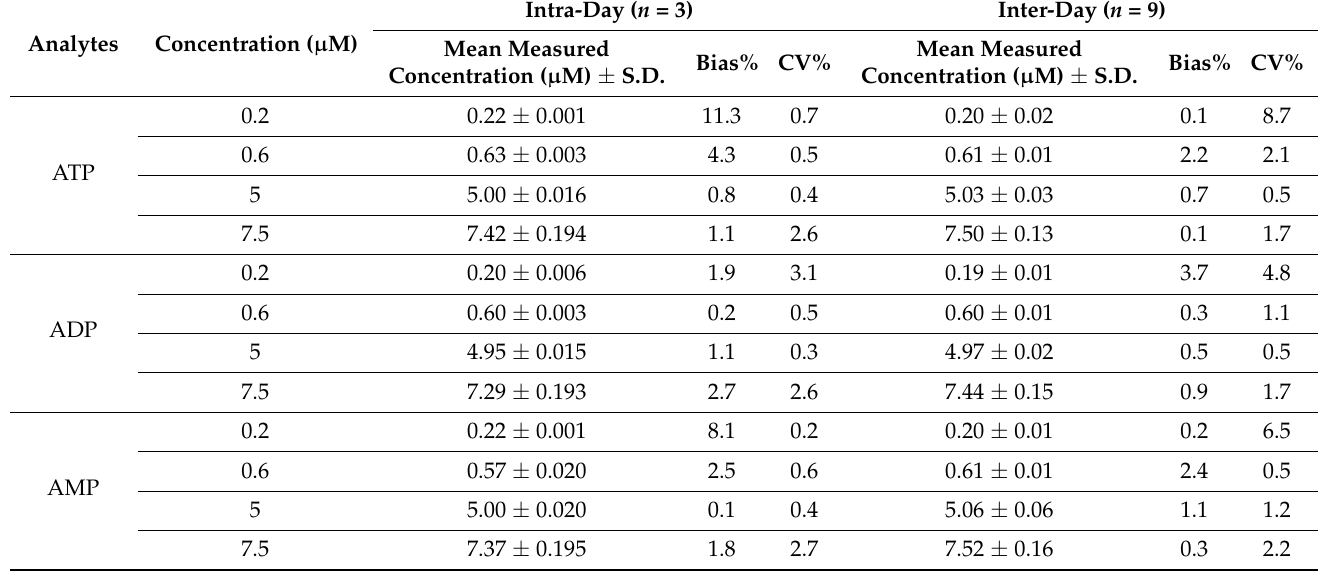
Table 2. Intra-day and inter-day accuracy (Bias%) and precision (CV%) of ATP, ADP, and AMP.